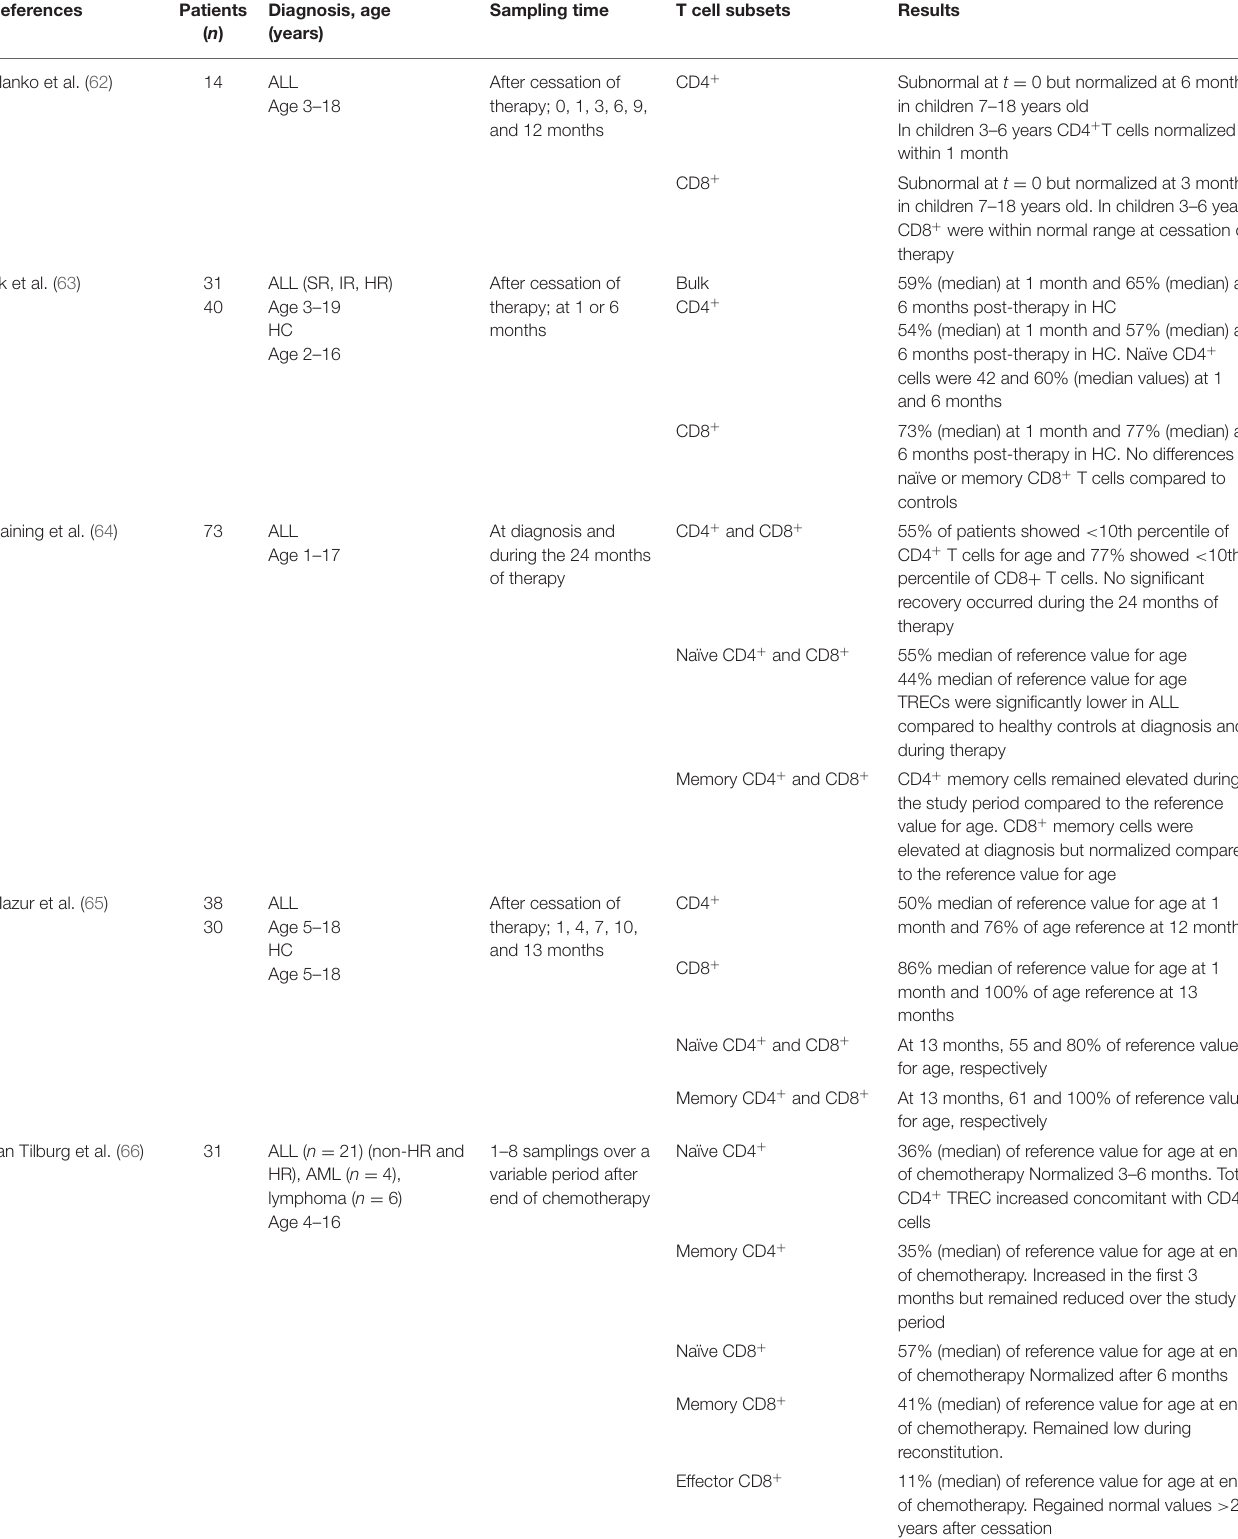
TABLE 1 | Peripheral T cell populations in children during and after ALL